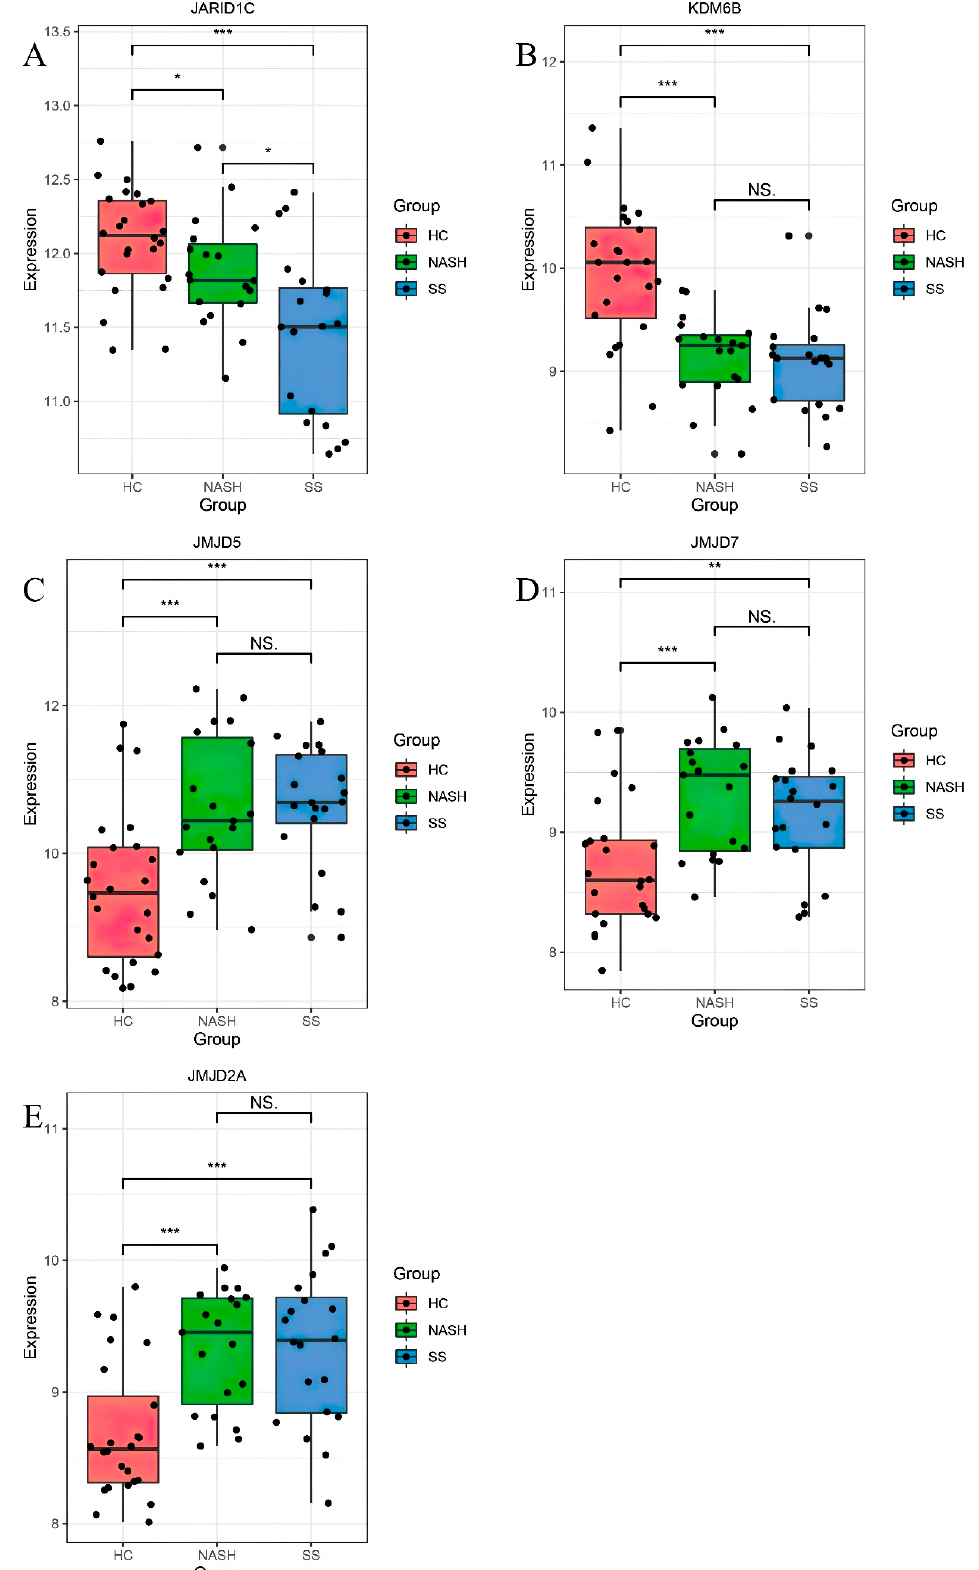
Figure 2. Differentially expressed HDM genes in the GSE89632 dataset. Abbreviations: SS, simple steatosis; HC, healthy control; NASH, nonalcoholic steatohepatitis; HDM, histone demethylase. p < 0.05 was signified as *, p < 0.01 as **, p < 0.001 as ***, and NS indicated not statistically